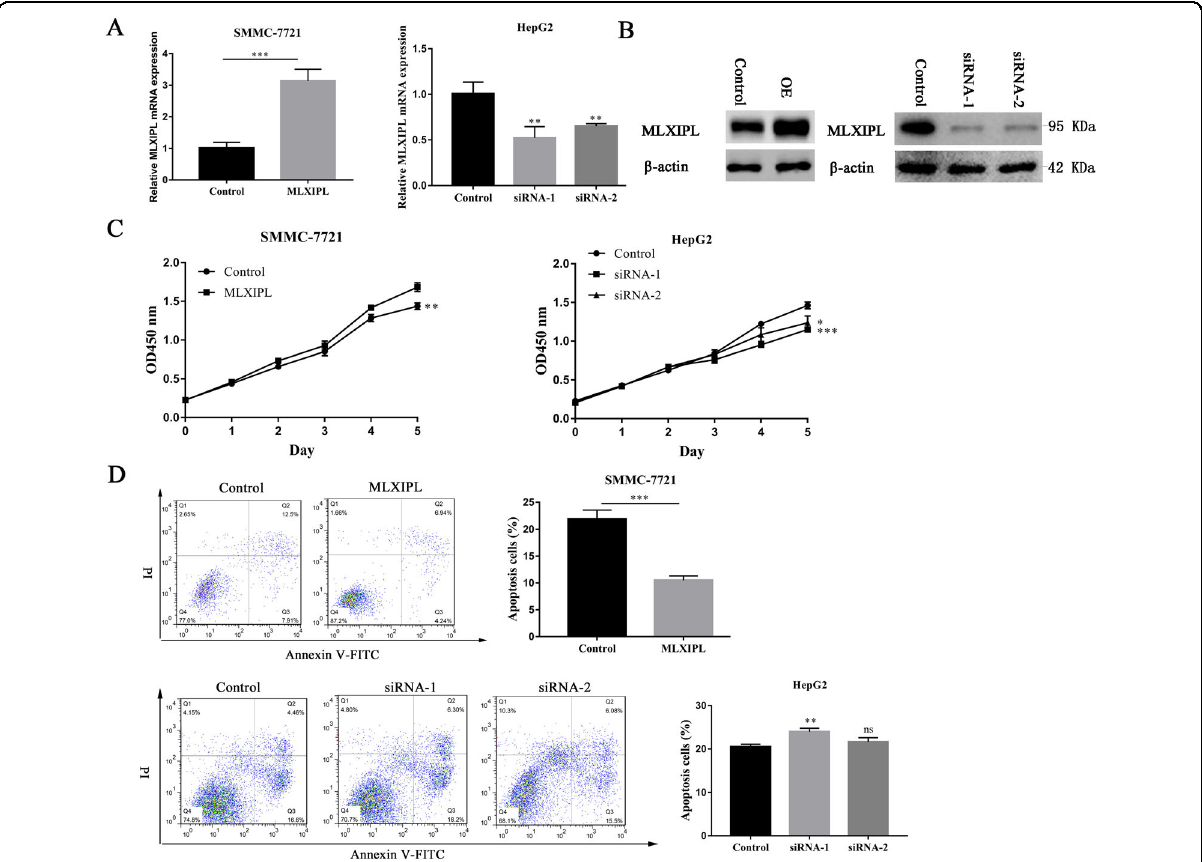
Fig. 6 MLXIPL promotes HCC proliferation and inhibits apoptosis in vitro. A , B The transfection effect of overexpressed MLXIPL plasmids or MLXIPL siRNAs was measured by quantitative real-time PCR and western blotting. ** P < 0.01; *** P < 0.001. C The proliferation ability in indicated cells was detected by the CCK8 assay after MLXIPL overexpression and knockdown separately in HCC cells. * P < 0.05; ** P < 0.01; *** P < 0.001. D Apoptosis analysis in indicated cells was detected after MLXIPL overexpression and knockdown separately in HCC cells. Representative data are featured, presenting the population of living cells (Annexin V ‑ FITC − /PI − ) in the left lower quadrant, early apoptotic cells (Annexin V ‑ FITC + /PI − ) in right lower quadrant, late apoptotic cells (Annexin V ‑ FITC + /PI + ) in the right upper quadrant and necrotic cells (Annexin V ‑ FITC − /PI + ) in the left upper quadrant. ns P > 0.05; ** P < 0.01; *** P <